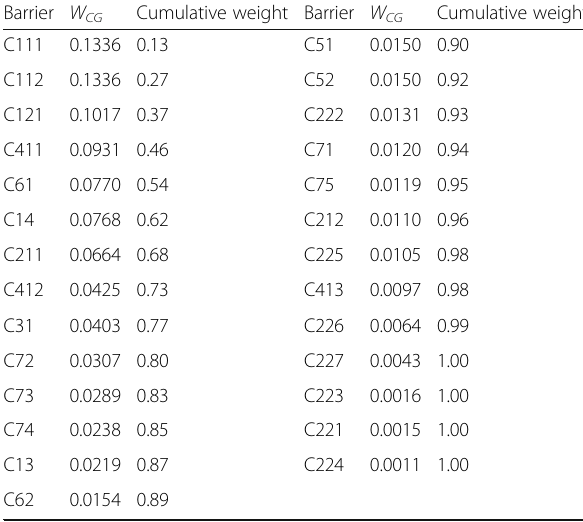
Table 7 Prioritised barriers, in descending order of preference, with their global normalised weight